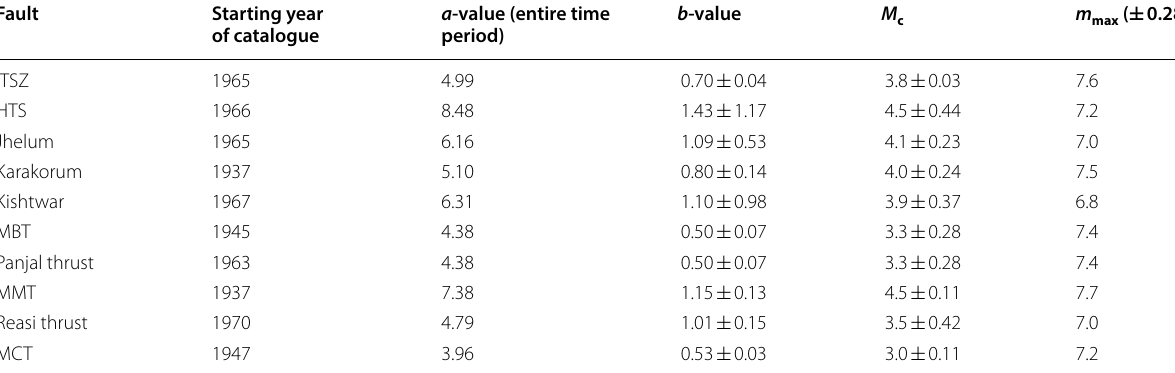
Table 2 Showing seismicity parameters, magnitude of completeness ( M the Kashmir basin from Sana and Nath (2017)